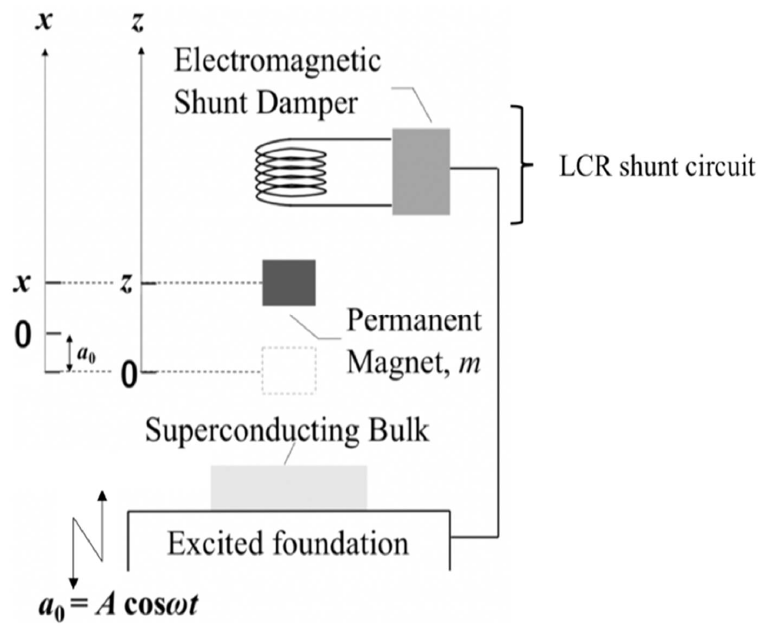
Figure 1. Analytical model of superconducting levitation system with an electromagnetic shunt damper.